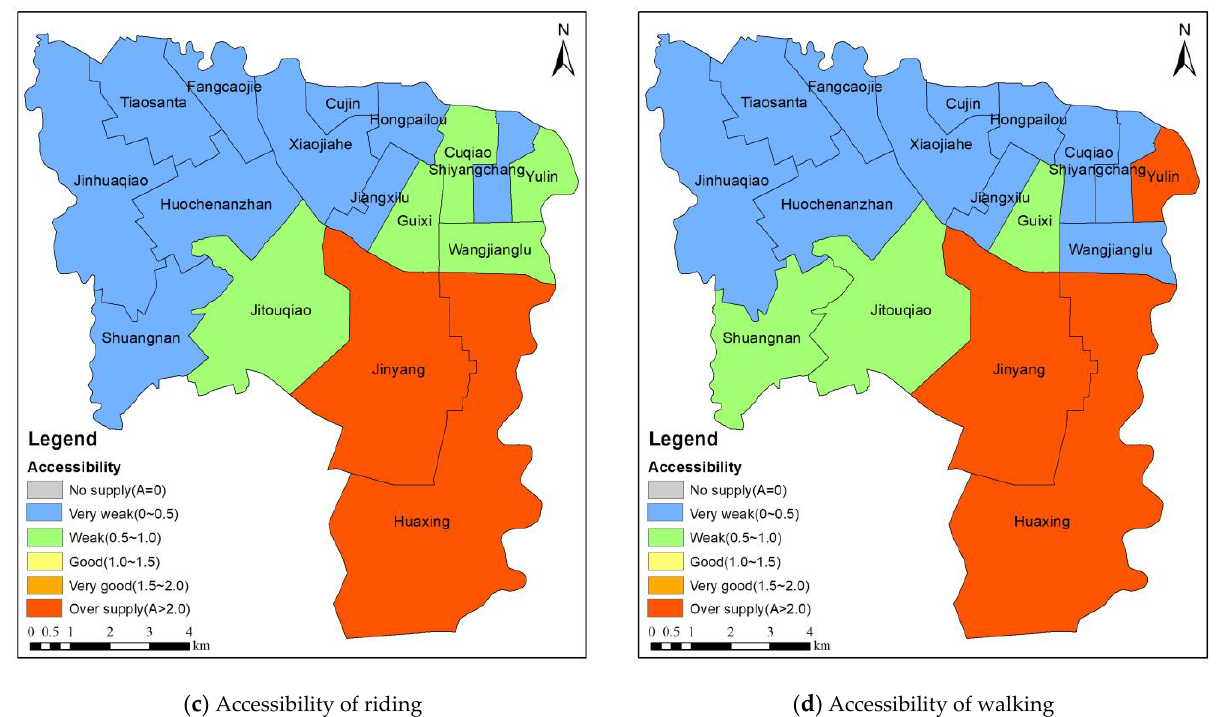
Figure 8. Park spatial accessibility in sub-district based on supply competition G2SFCA method.